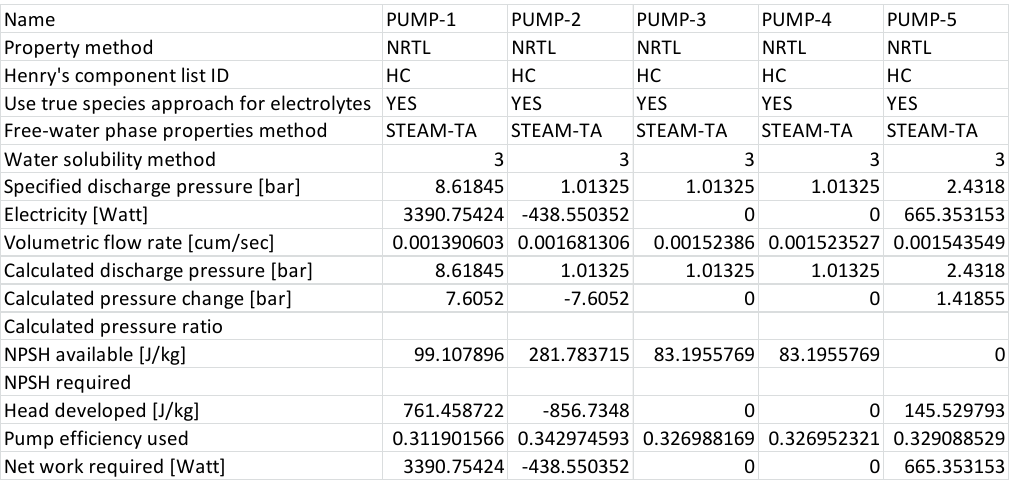
Figure A13. Fermentation pump results.